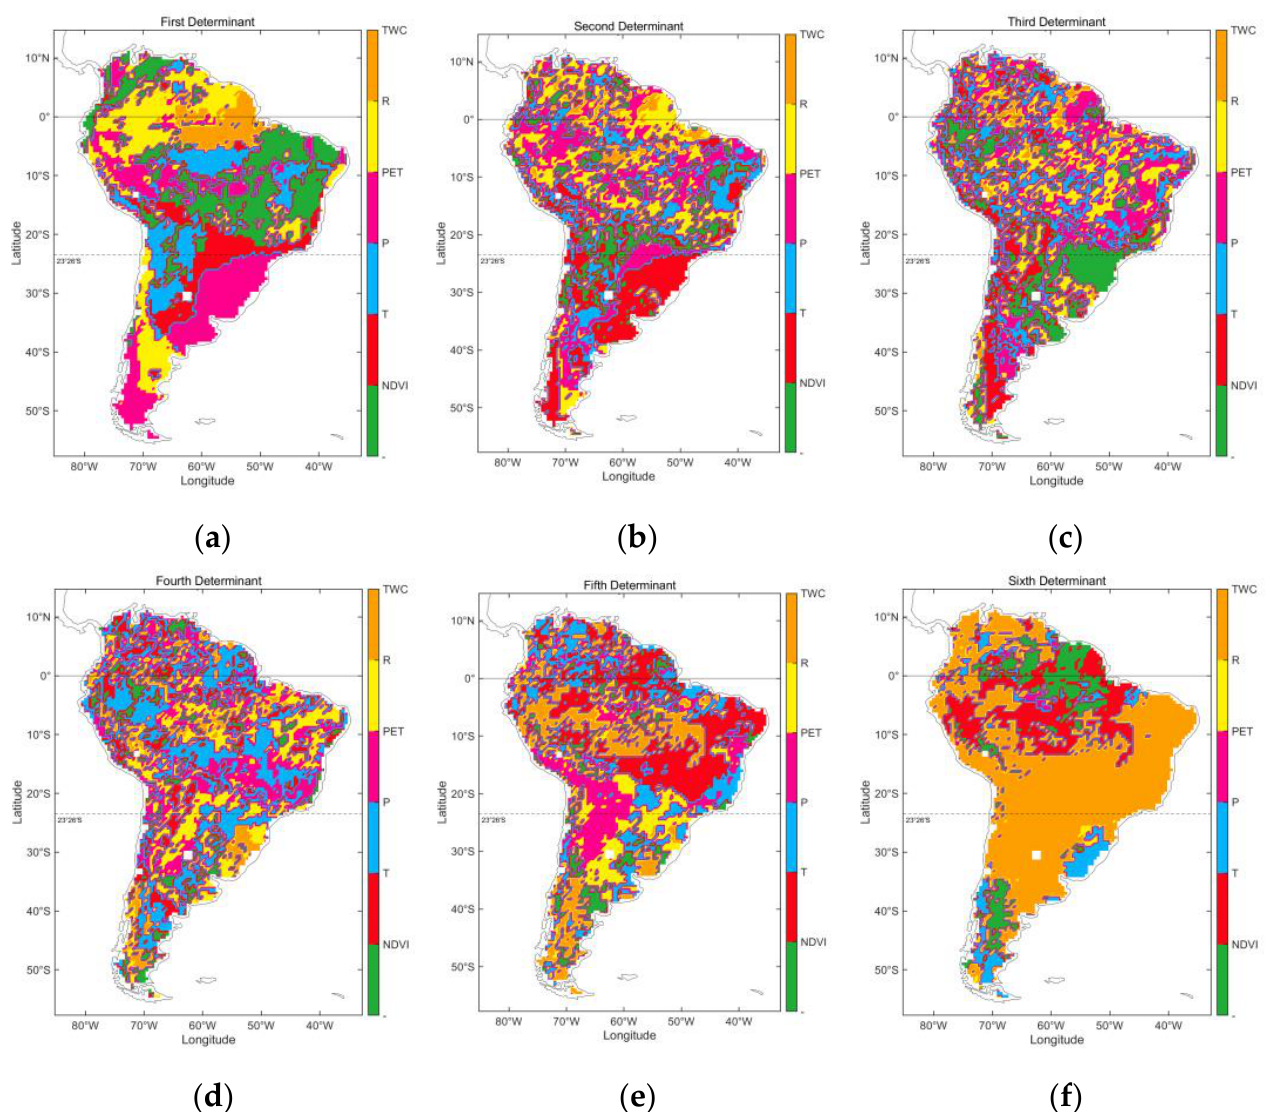
Figure 8. Map of determinants for AET at each order from Boruta. ( a ) First, ( b ) Second, ( c ) Third, ( d ) Fourth, ( e ) Fifth, and ( f ) Sixth.